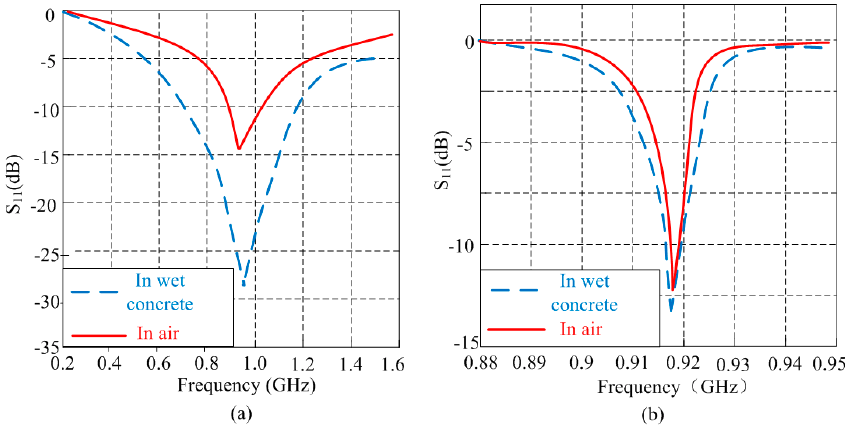
Figure 2. Computed S-parameters of two antennas coupling in free space and wet concrete: ( a ) return loss of dipoles; ( b ) return loss of patches.